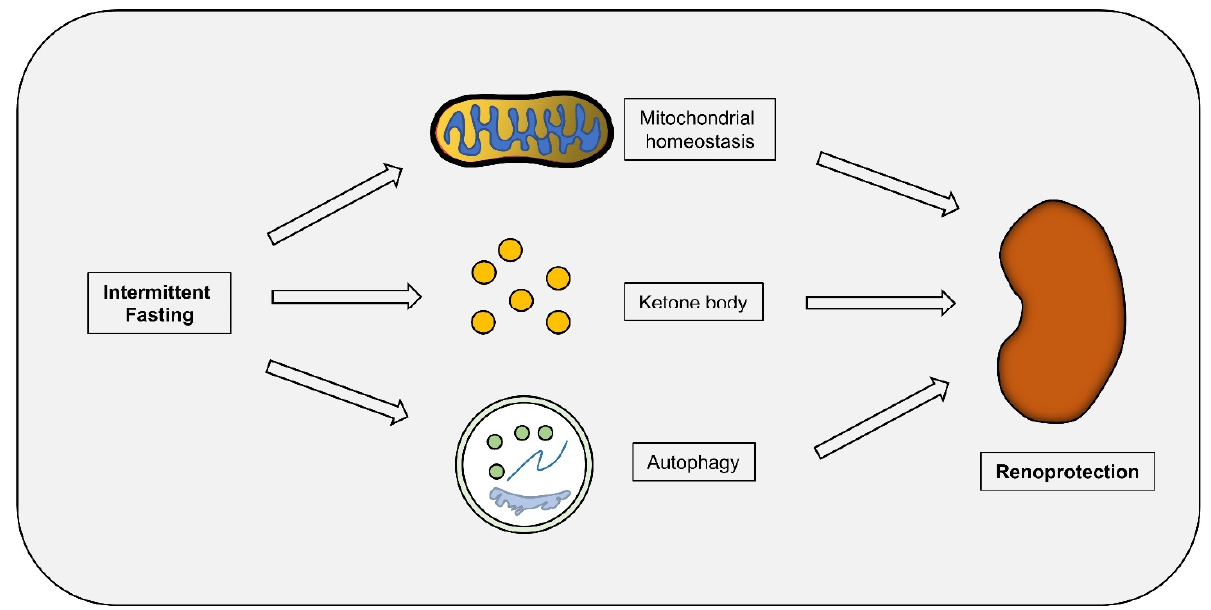
Figure 2. The potential mechanisms underlying the protective effect of IF in DN progression. IF dietary patterns maintain mitochondrial homeostasis, increase the production of ketone bodies, and promote autophagy, thereby delaying DN progression.